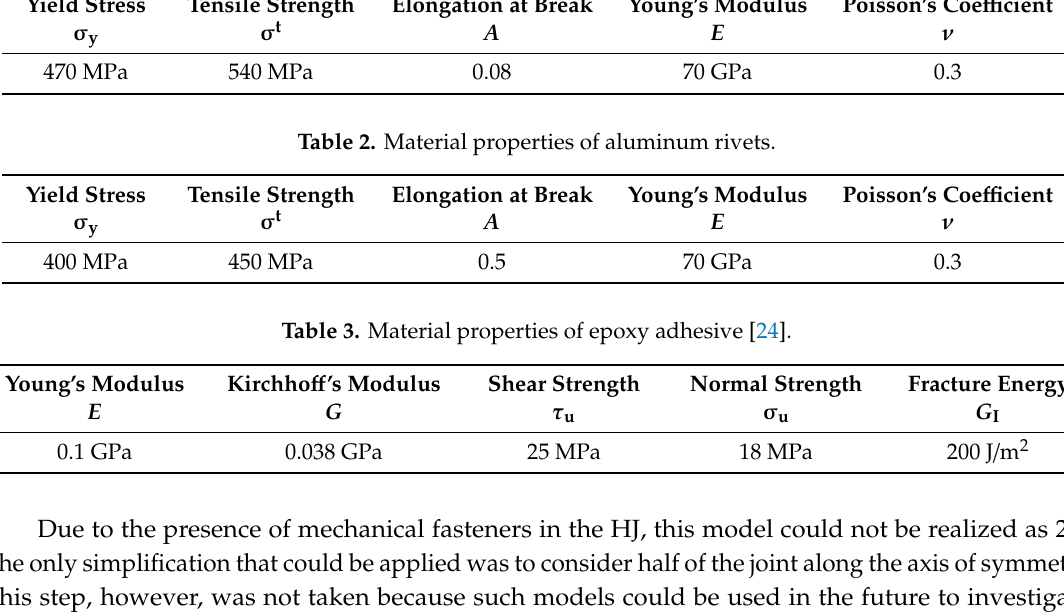
Table 1. Material properties of aluminum plates.